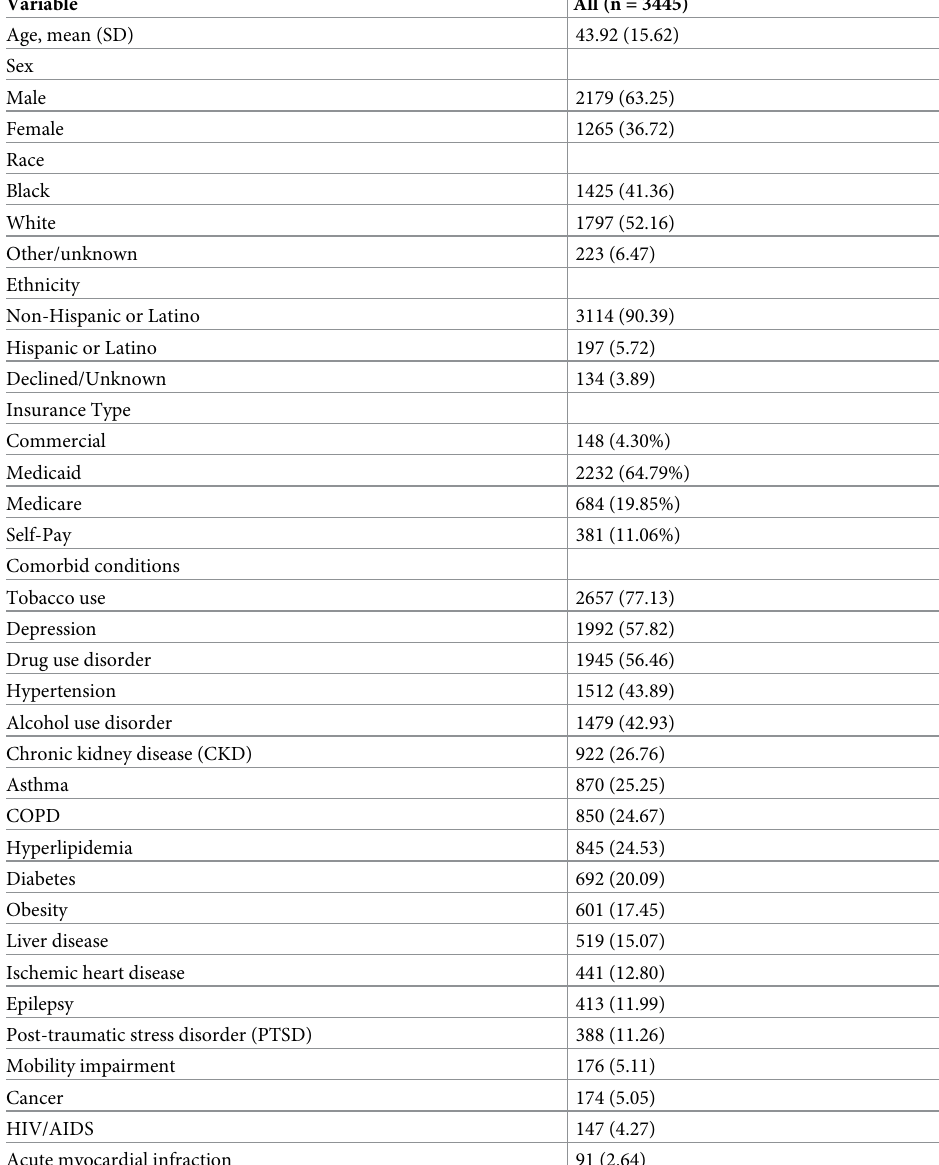
Table 1. Descriptive statistics of the study population. The values are count and percent unless otherwise